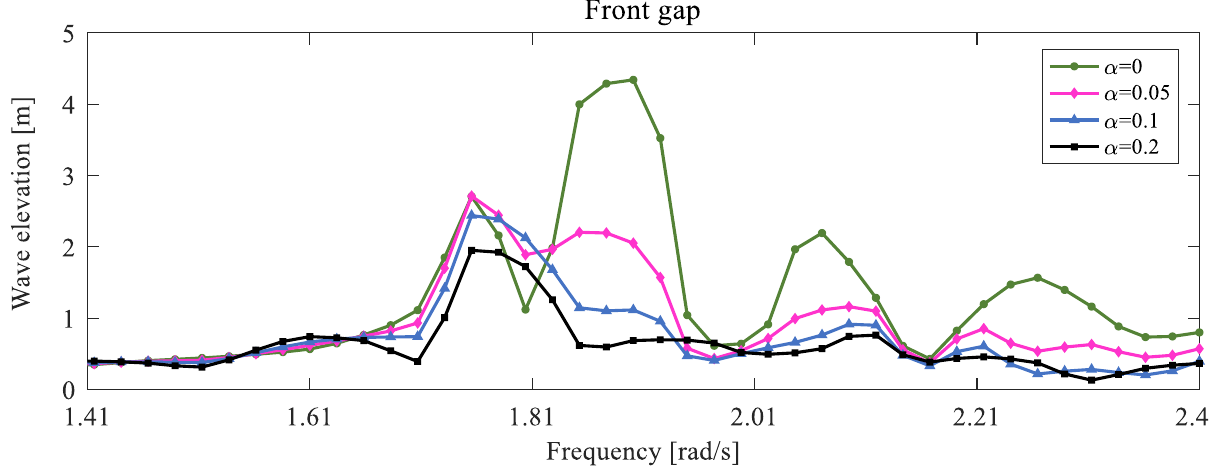
Figure 10. Free surface elevation in the front gap under different artificial damping ratios.